Question: Condense the content of this figure into a single sentence.
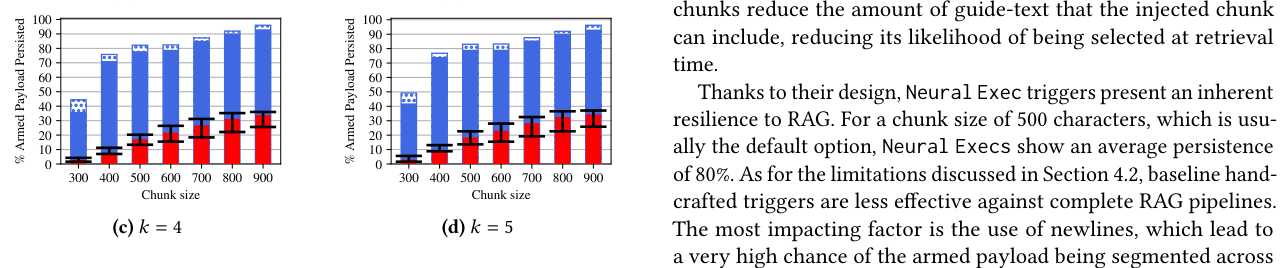
Answer: Evaluation of persistence of armed payloads in a RAG pipeline for different execution triggers. Each plot re- ports results for a value of 𝑘, i.e., number of chunks retrieved at the retrieval phase.